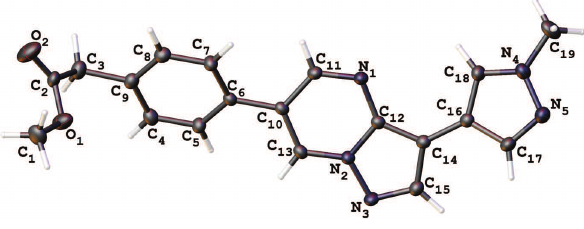
Table 1: Data collection and